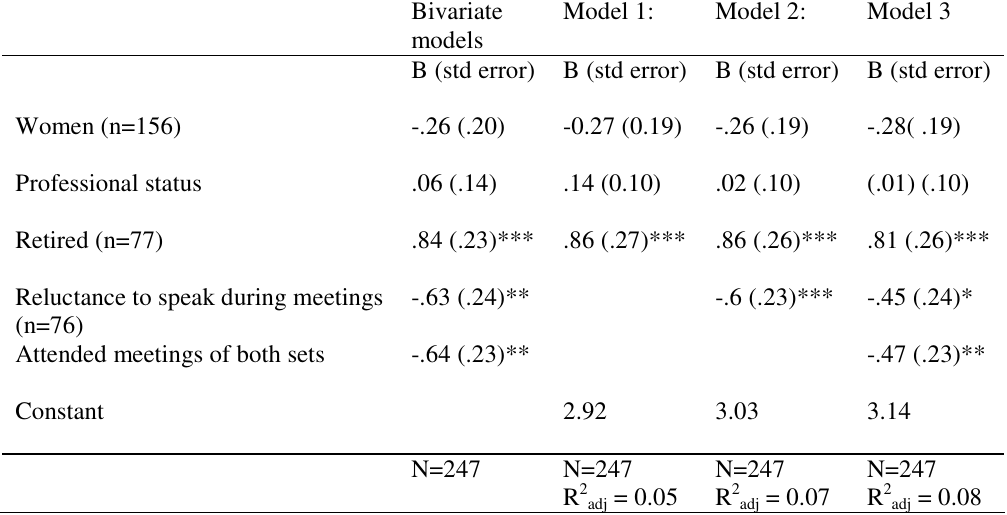
Table 4. The effects of departures from the ideal of political equality on perceived procedural